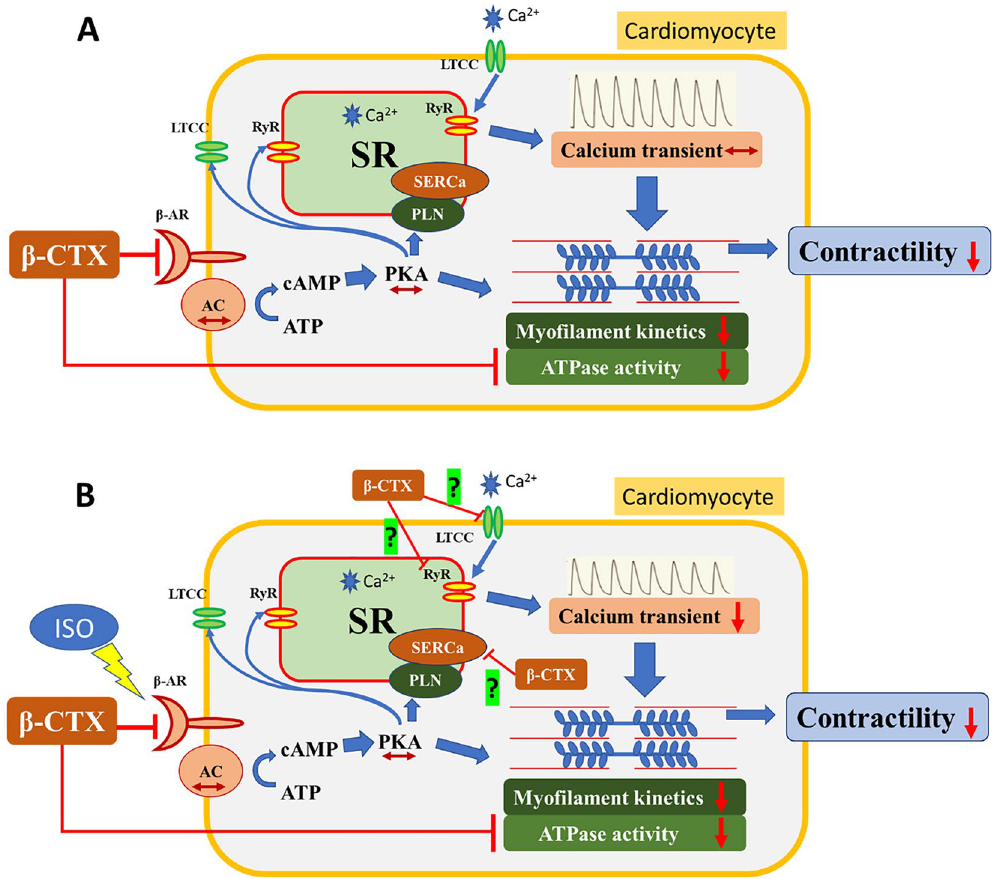
Figure 8. The diagram illustrates the proposed mechanisms of action of β-CTX. The β-CTX may non- competitively block the β-adrenergic receptor (β-AR) without affecting the downstream signaling. (A) Under the non-stimulating condition, the β-CTX directly reduces the myofibrillar ATPase activity, resulting in the reduction of myofilament kinetics and contractility. The calcium transient is, therefore, unaffected. (B) Under the stimulating condition with ISO, the cAMP-PKA pathway, however, could not be activated. The calcium transient is decreased likely due to the inhibition of SERCa. The effect of β-CTX on LTCC and RyR is unknown and awaits further